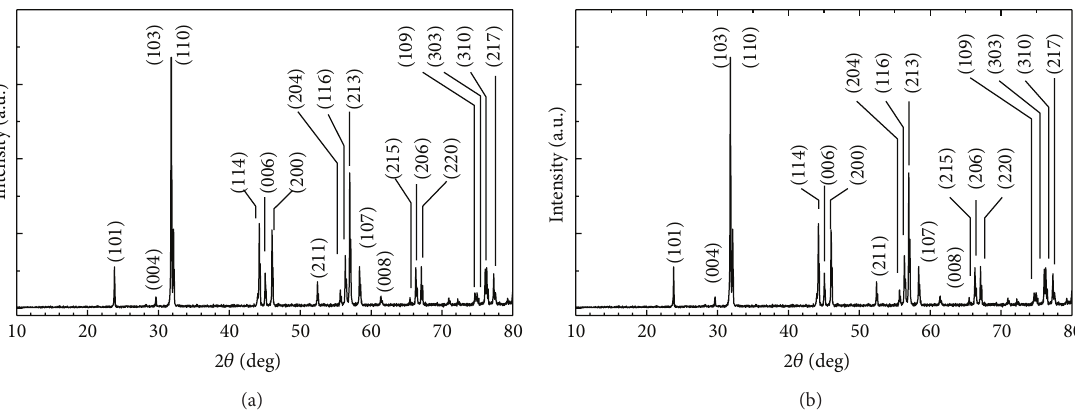
Figure 1: X-ray diffraction patterns of Nd 1.85 Ce 0.15 CuO 4−𝛿 powders (a) before and (b) after ammonothermal treatments at 54 ∘ C in sodium ammonia solutions.